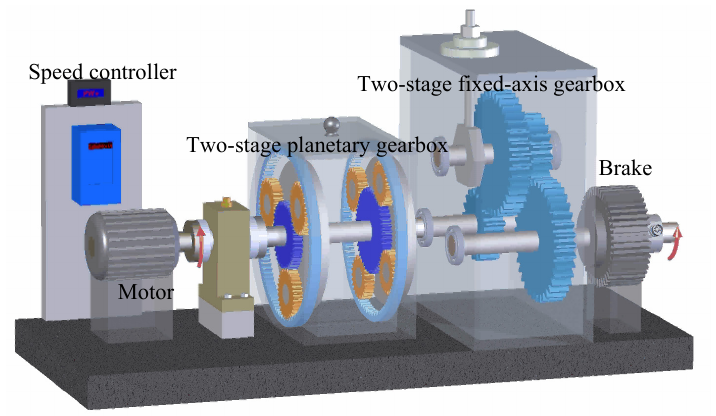
Figure 3. Schematic model of a two-stage planetary gearbox test rig.